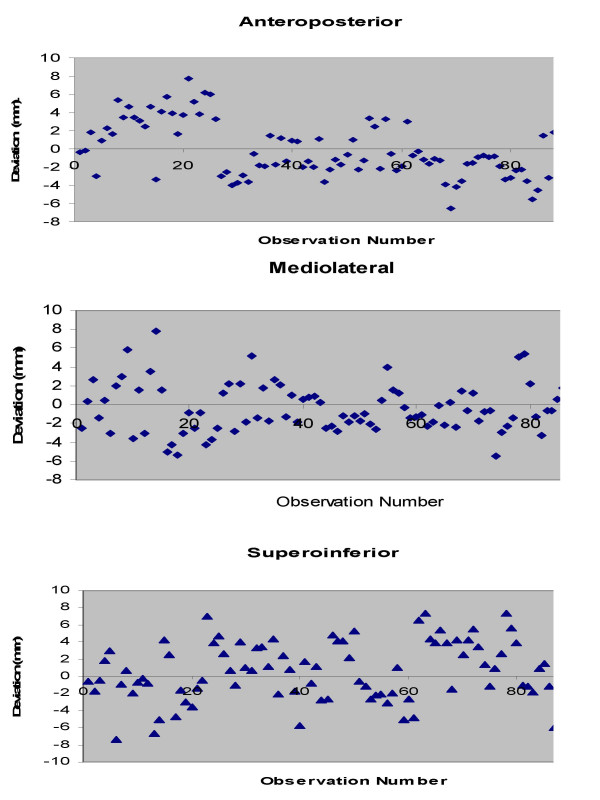
Scatterplot of translational displacements for all observations in all three directions.